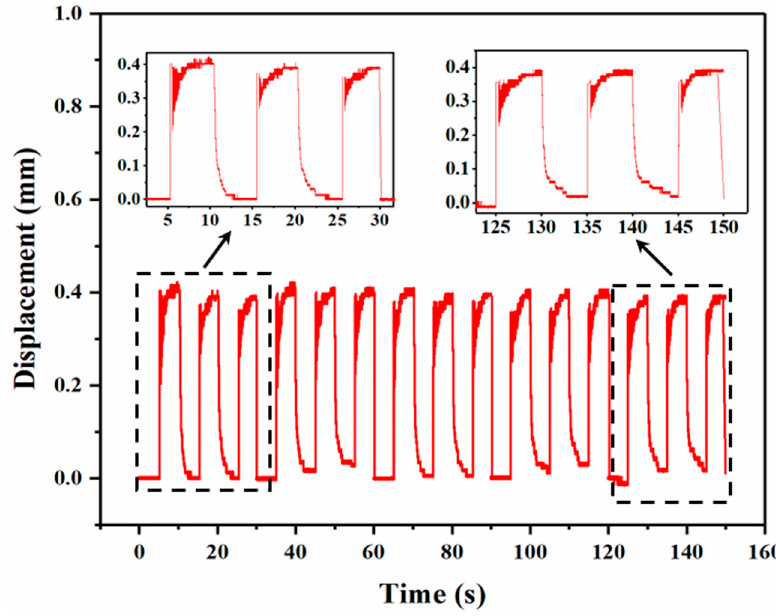
Figure 12. The performance of the actuator when it experiences periodic input voltage (12 kV, 20 Hz) for a long time under load.